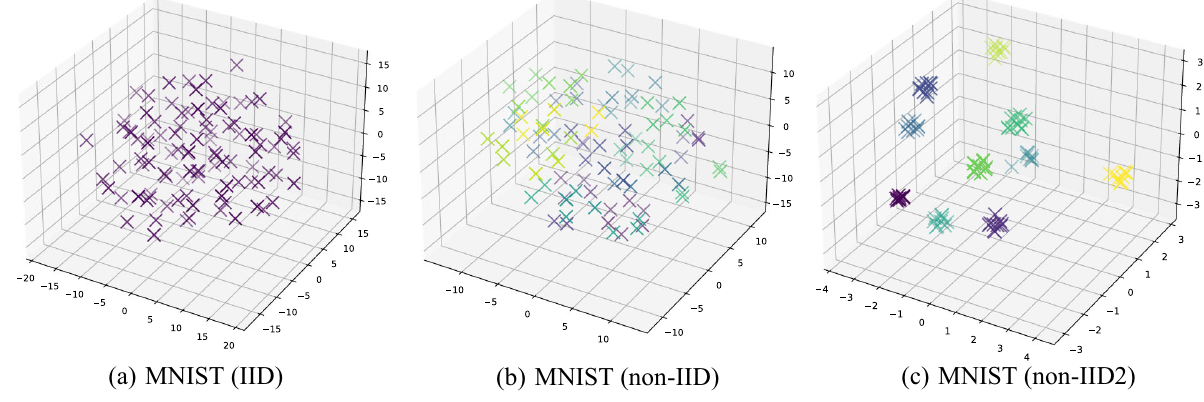
Fig. 3 Clustering results of model parameters under different heterogeneous setting on MNIST dataset (moderate device number)